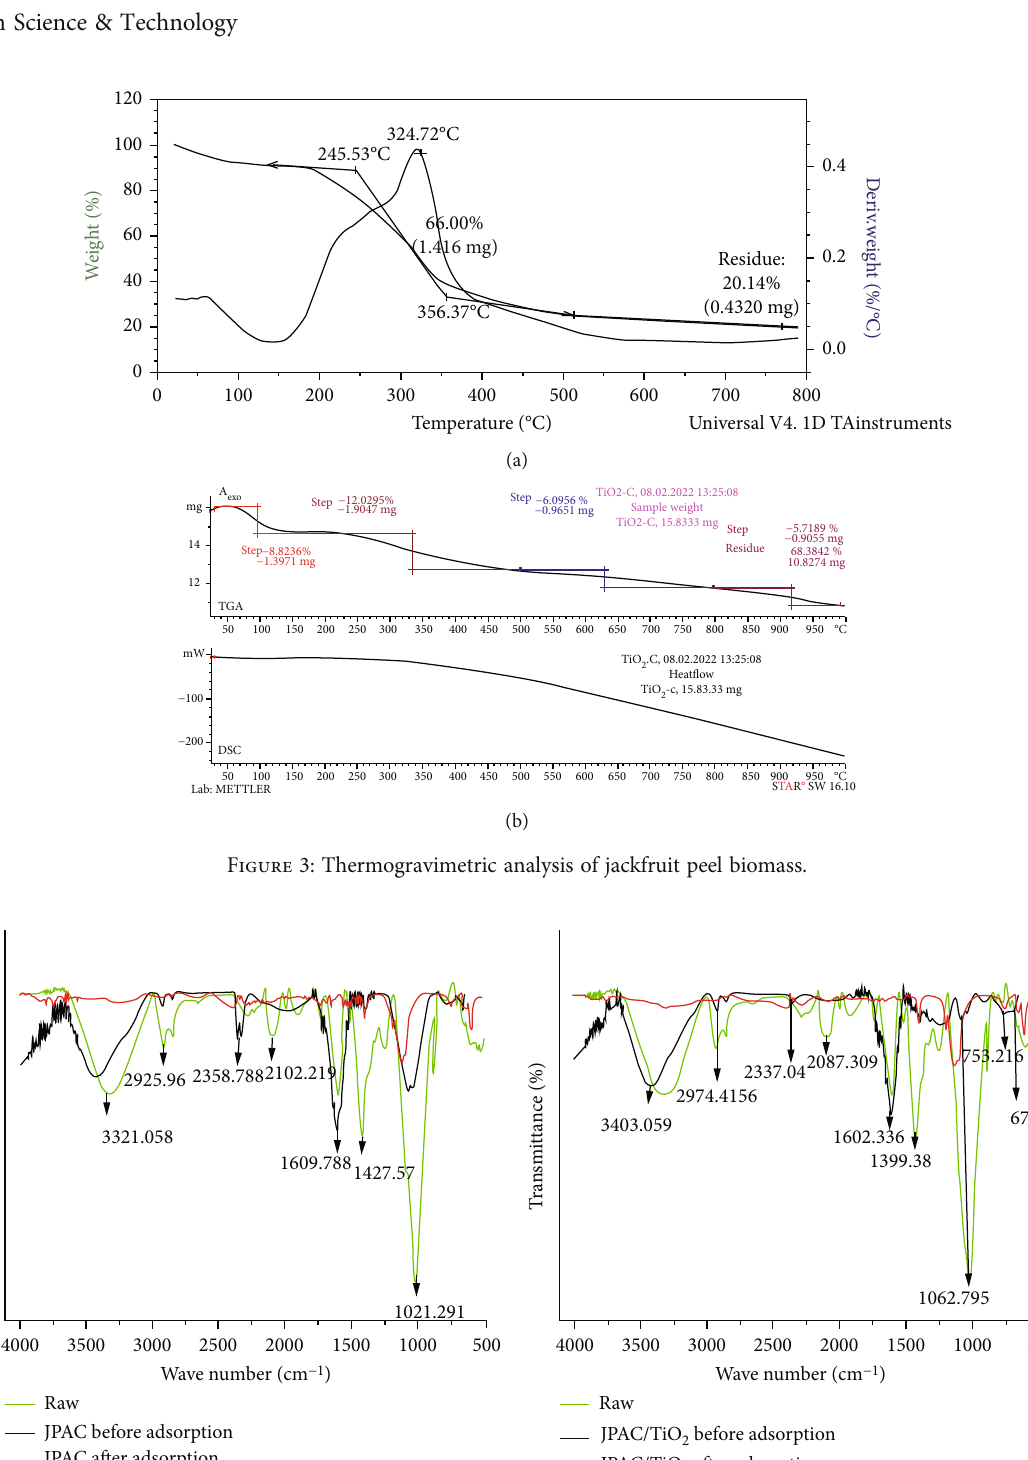
Figure 4: FTIR analysis of (a) JPAC and (b) JPAC/TiO